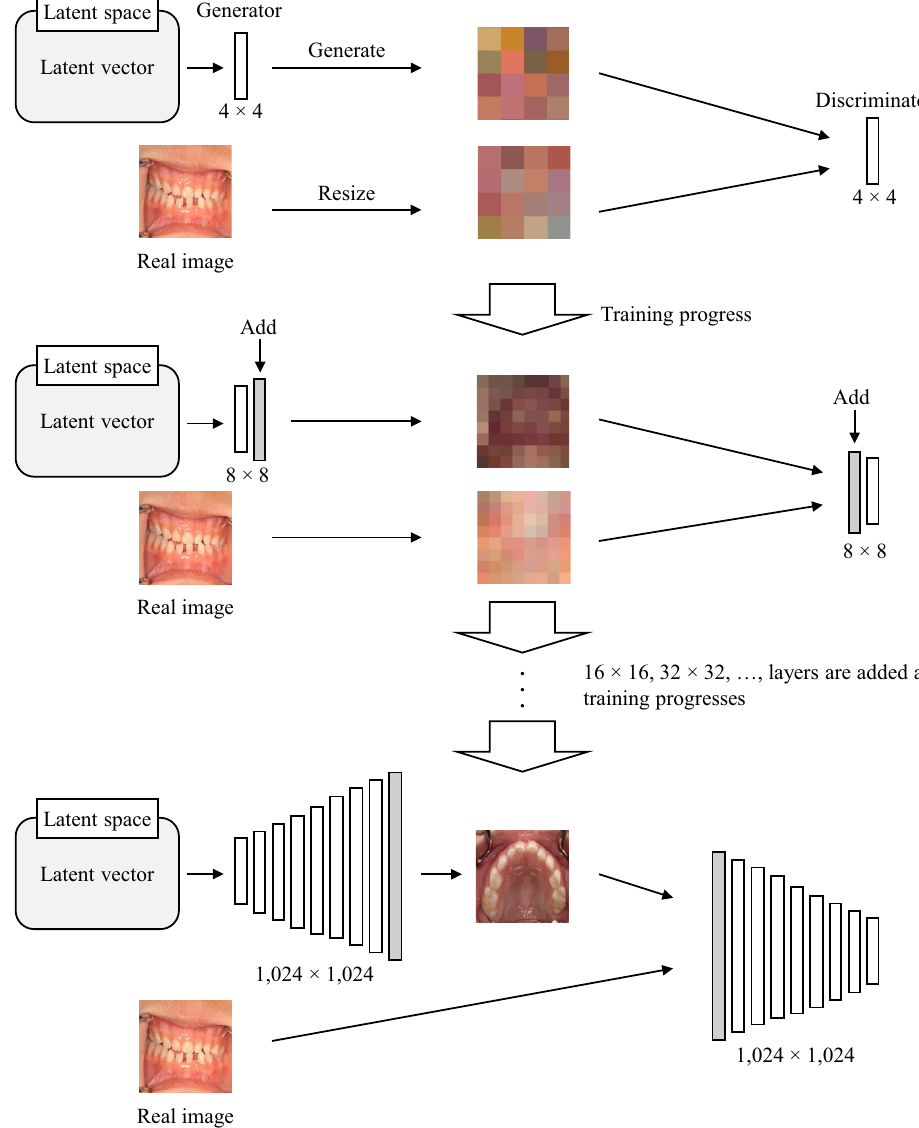
Figure 1. The architecture of progressive growing generative adversarial networks